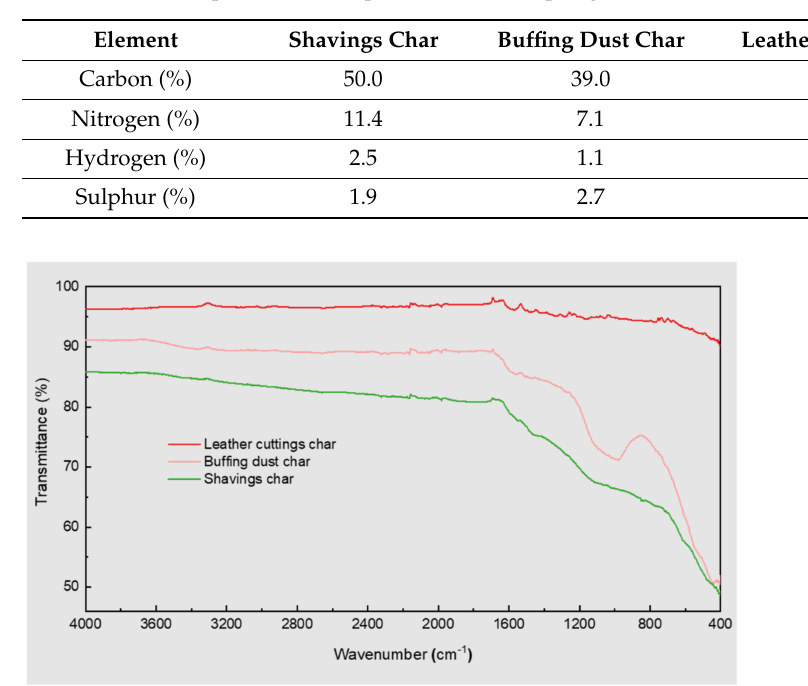
Table 3. Chemical composition of prepared char from leather wastes. (Adapted from Nur-A- Tomal, et al. [7]. Reproduced with permission from Springer Nature).